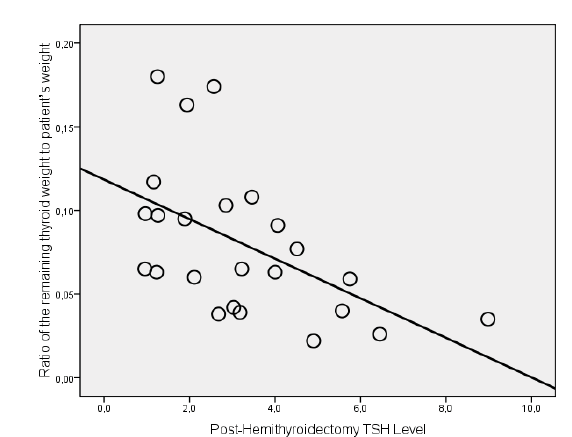
Figure 2. Changes of postoperative serum TSH level: it is decreasing in patients who didn’t take thyroid hormone postoperatively; TSH: thyroid-stimulating hormone. Changes of postoperative serum TSH